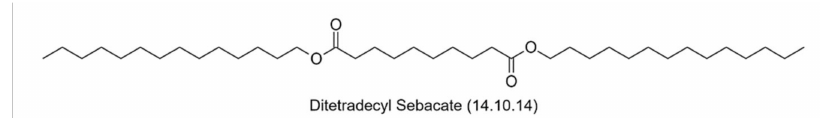
Figure A2. Chemical structure and IUPAC names of the diesters presented by Aydin et al. [24] and reproduced in this study to validate the synthesis procedure. The carbon number of the corresponding precursor dicarboxylic acid and alcohol are reported in brackets. DiTeOHSe is the product of two 1-tetradecanols (C 14 ) attached at the extremes of a central sebaci acid molecule (C 10 ). Therefore, it is indicated as 14.10.14.